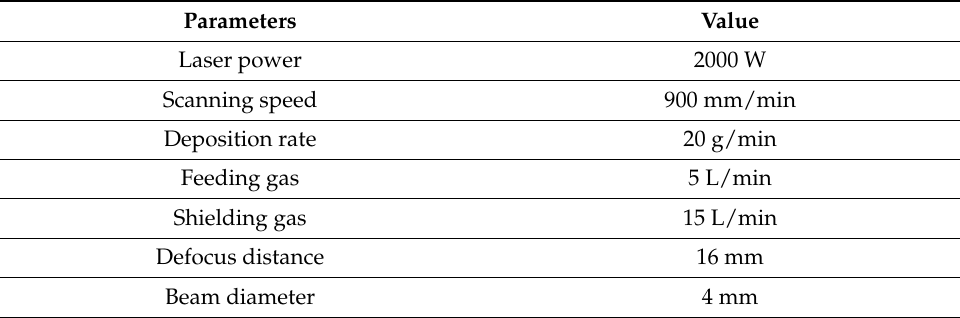
Table 3. Experimental parameters of the DED process.